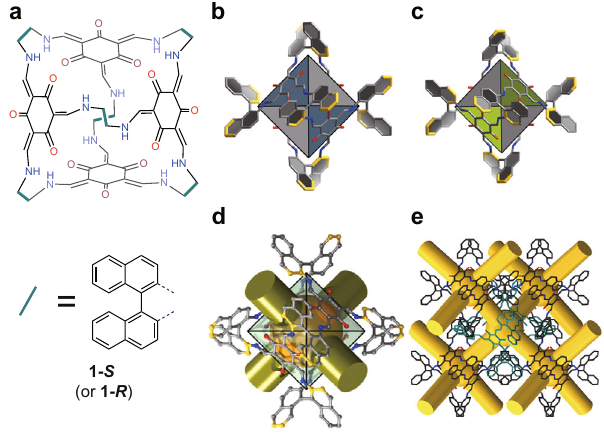
Fig. 1 Structure of chiral enantiomer of PAC 1. a Chemical structure of the S or R cage in PAC 1 . b , c The polyhedral structure of S and R cage in PAC 1 with conjugated planar in blue or green. d The representation of cavity and windows in 1- R . e The packing of 1- R with 3-D diamondoid pore network.